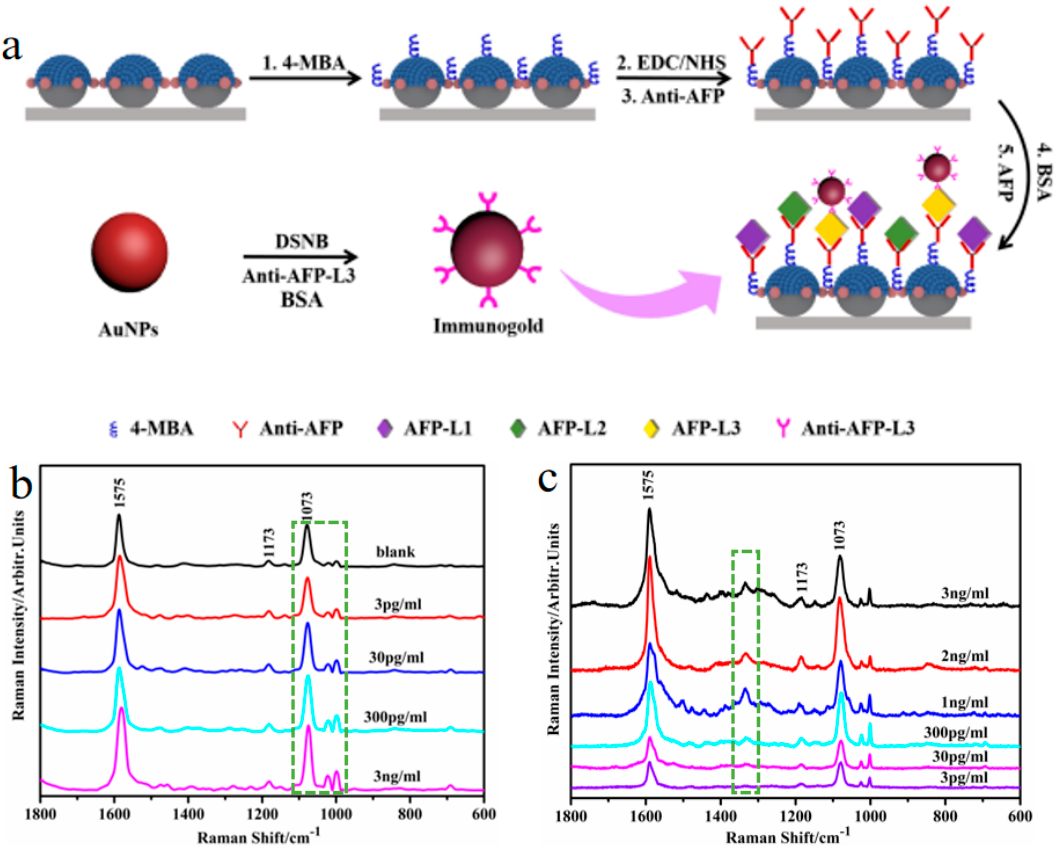
Figure 6. ( a ) The preparation schematic diagram of SiO 2 − Ag nanocap arrays as a biomarker chip. ( b – c ) The SERS spectrum of the biomarker chip for different α -fetoprotein (AFP) and α -fetoprotein-L3 (AFP-L3) concentrations, respectively. Reproduced from [39] with permission from Elsevier, 2020.